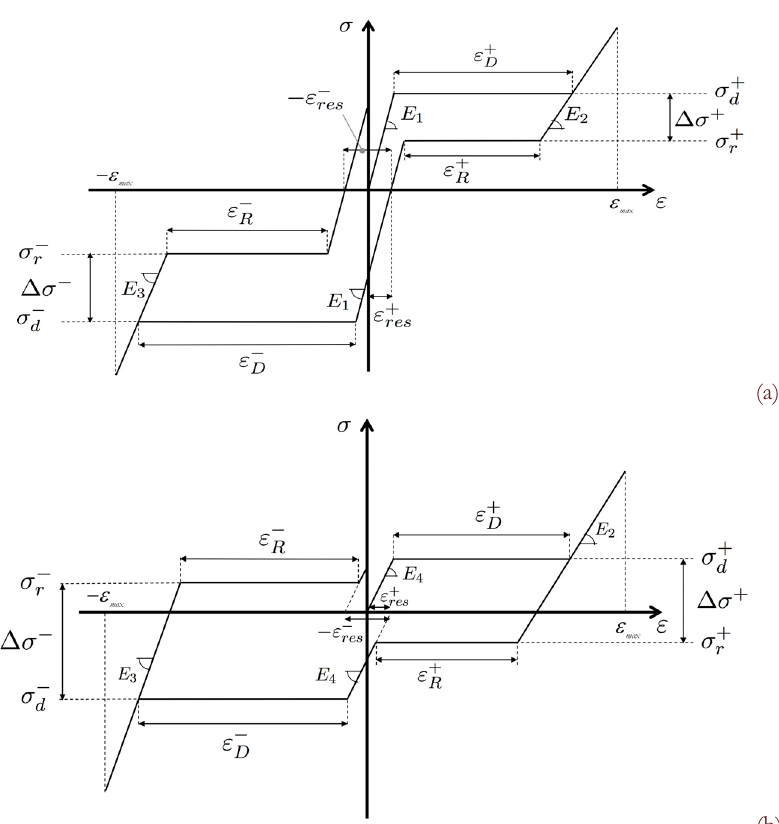
Figure 5: Stress  vs. strain  predicted by present model in a tensile-compressive loading-unloading test obtained from applied strain as in Fig. 2 at the high temperature